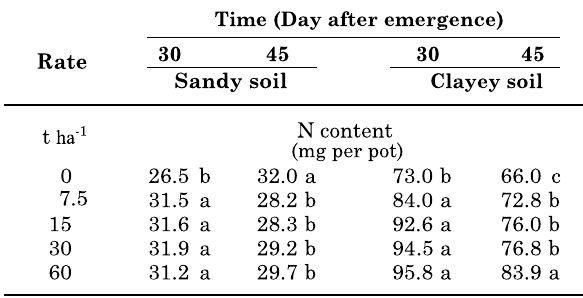
Table 6. Changes in N accumulation (mg/pot N) of cowpea growing in soils amended with composted tannery sludge